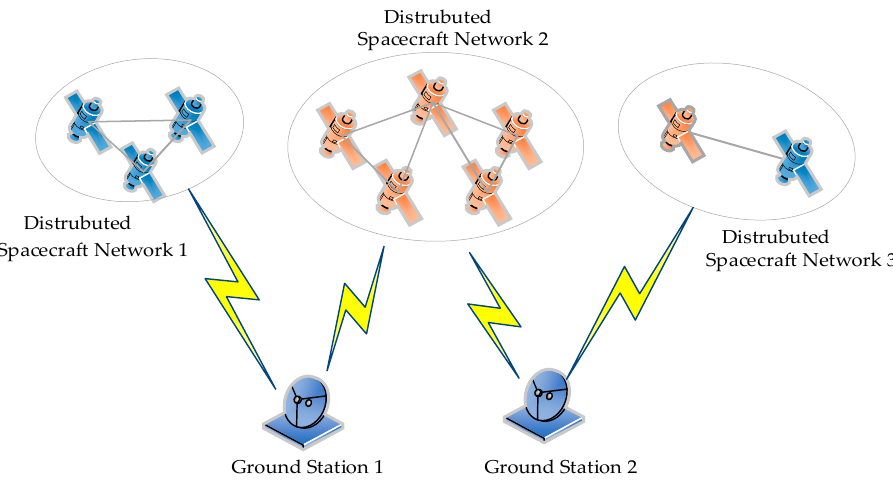
Figure 1. Structure of distributed spacecraft networking.